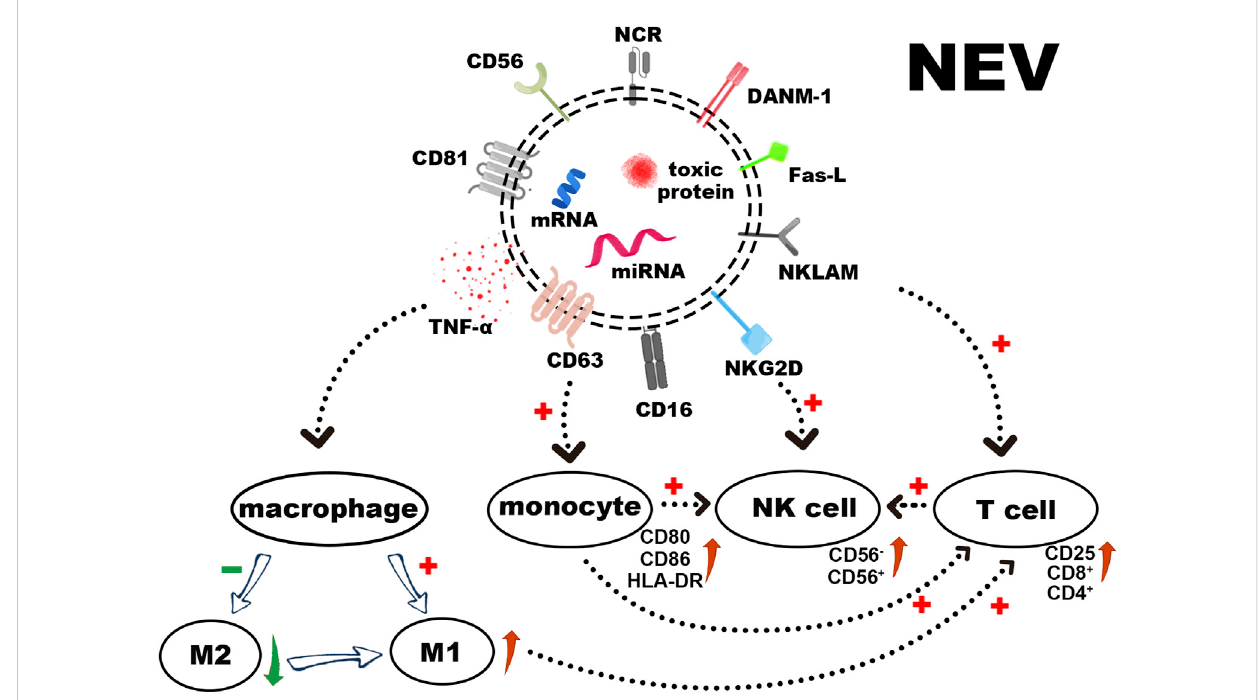
FIGURE 2 The surface receptors of NEVs, loaded cytotoxic proteins, and functional miRNAs induce apoptosis in tumor cells. In addition to stimulating the polarization of macrophages towards M1 and activating T cells directly or via activated monocytes, NEVs can also activate resting NK cells, thereby augmenting their tumor-killing